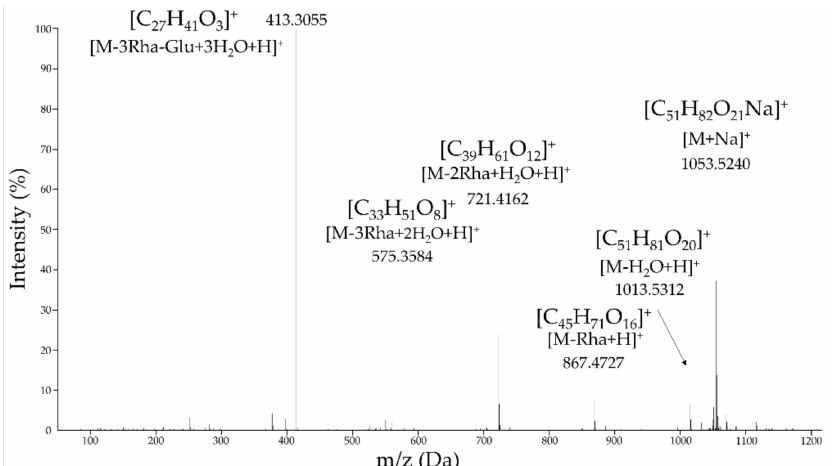
Figure 4. High resolution mass spectrum (ESI + ) of the amorphous precipitate which corresponds to ECn-F4-25. The molecular ion and fragmentation pattern of the pure compound is showed. The maximum permissible mass error for elemental analysis was below ± 5